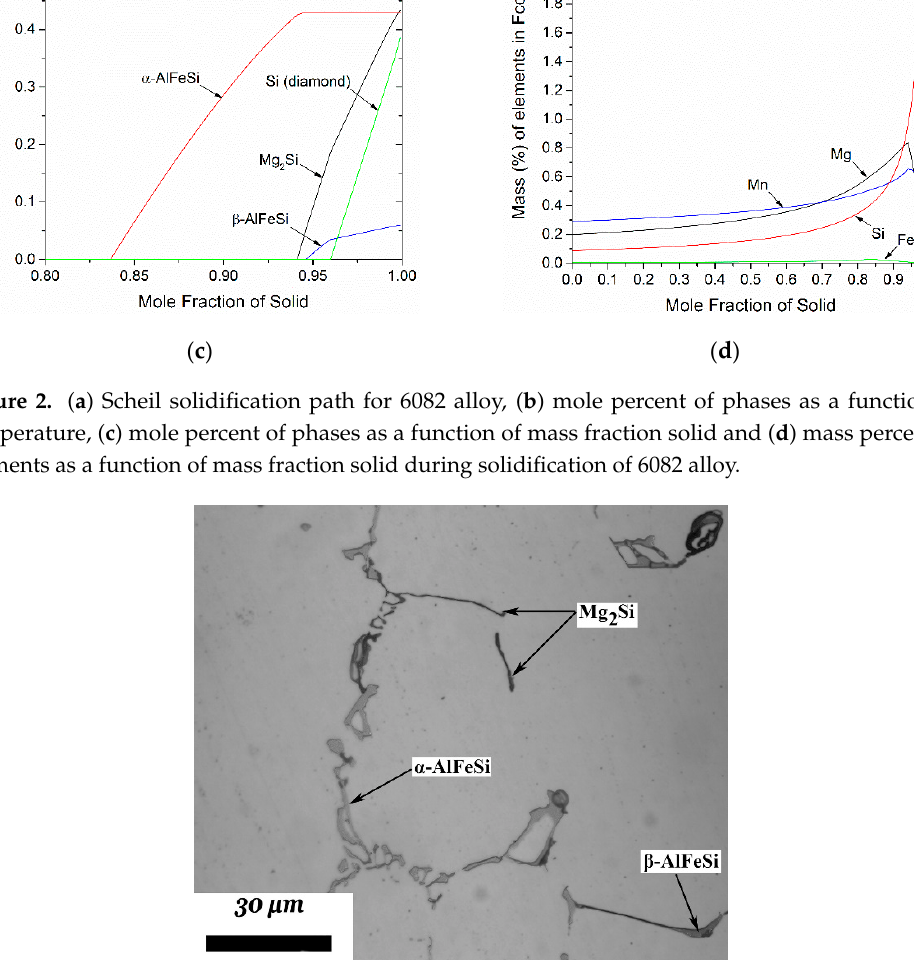
Figure 2. ( a ) Scheil solidification path for 6082 alloy, ( b ) mole percent of phases as a function of temperature, ( c ) mole percent of phases as a function of mass fraction solid and ( d ) mass percent of elements as a function of mass fraction solid during solidification of 6082 alloy.